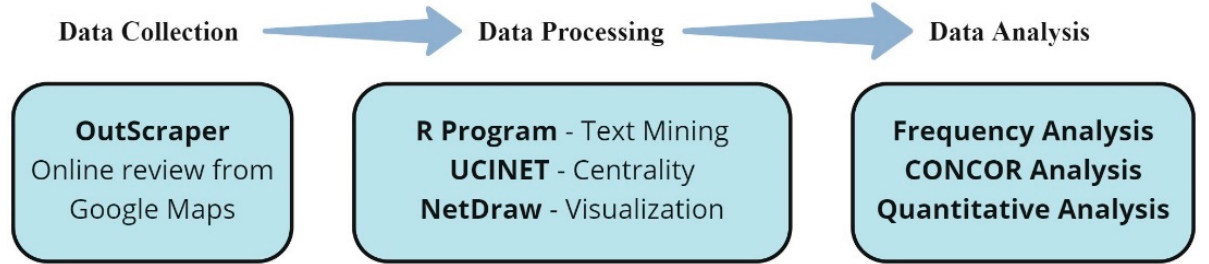
Figure 1. Research Procedures.